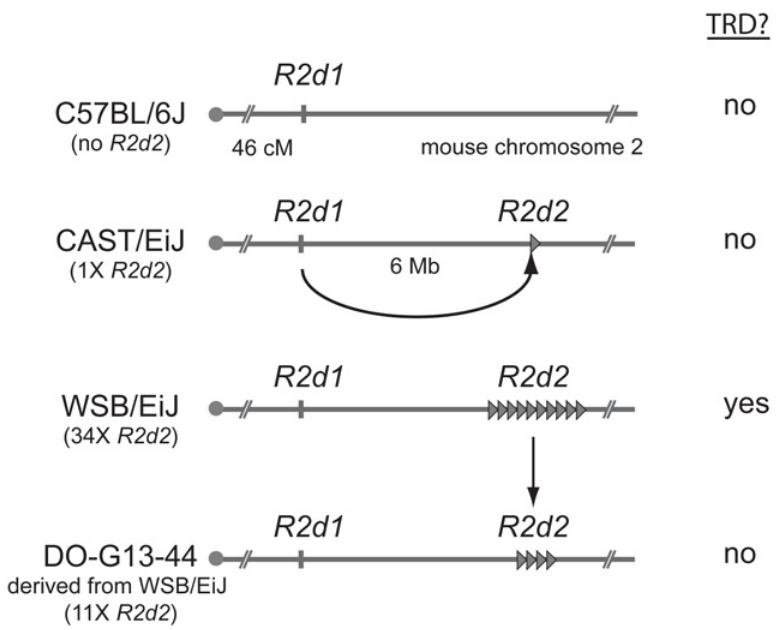
Figure 1. Transmission ratio distortion (TRD) caused by a high copy R2d2 array. In the absence of the R2d2 sequence (e.g., C57BL/6J), or when the copy number of the sequence is low (e.g., CAST/EiJ), allele transmission through heterozygous females is Mendelian and no embryonic lethality is observed. When the copy number is high in the appropriate genetic background (e.g. WSB/EiJ), the litter sizes of heterozygous females are reduced and the R2d2 locus shows TRD. When the copy number of R2d2 repeats decreases (e.g., DO-G13 – 44), litter sizes increase and Mendelian segregation is